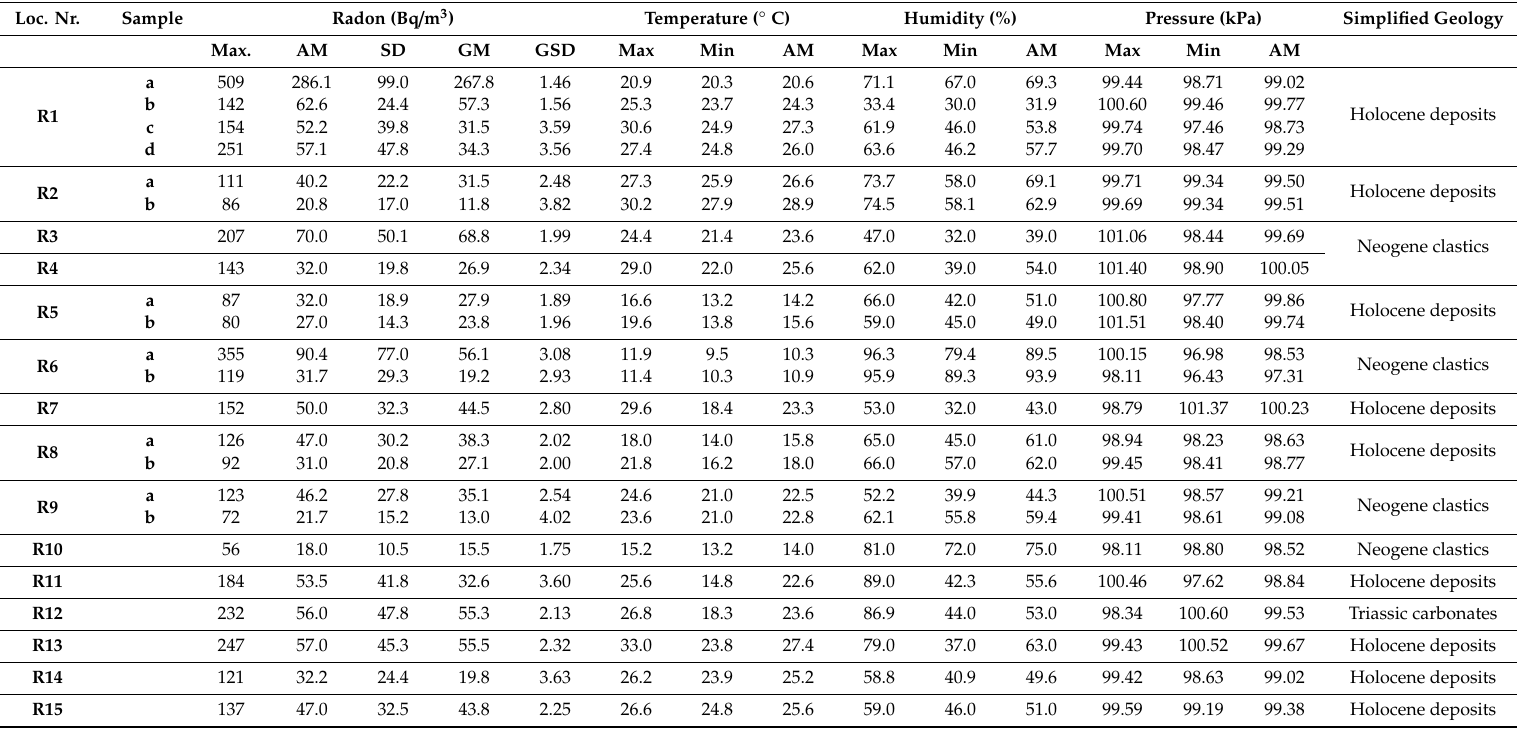
Table 2. Descriptive statistics (maximum, arithmetic mean (AM), standard deviation (SD), geometric mean (GM), geometric standard deviation (GSD)) of the radon indoor testing data with temperature, humidity and air pressure conditions (minimum, maximum and arithmetic mean) for randomly selected buildings in Northern Croatia. Simplified geological units of each location are shown in the last column [22]. Loc.